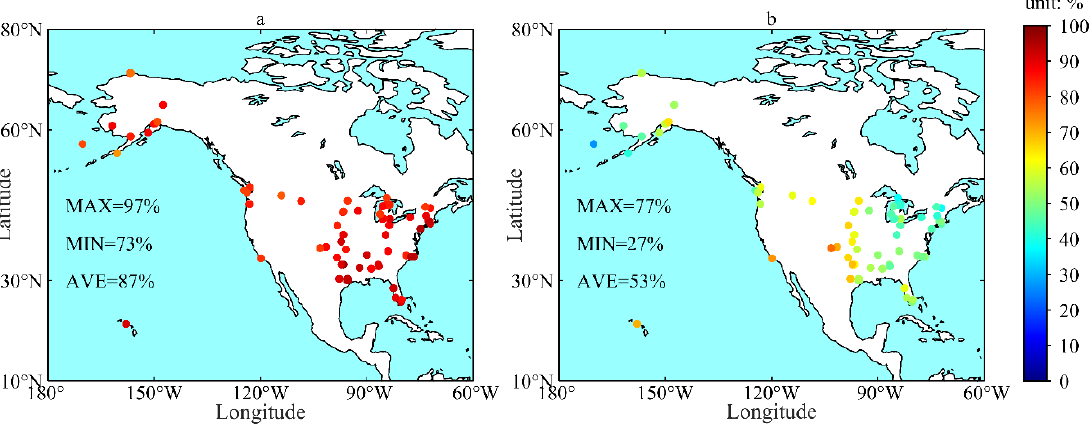
Figure 8. ( a ) POD and ( b ) FAR at 66 rainfall stations from the data for the 2-year period from 2019 to 2020.